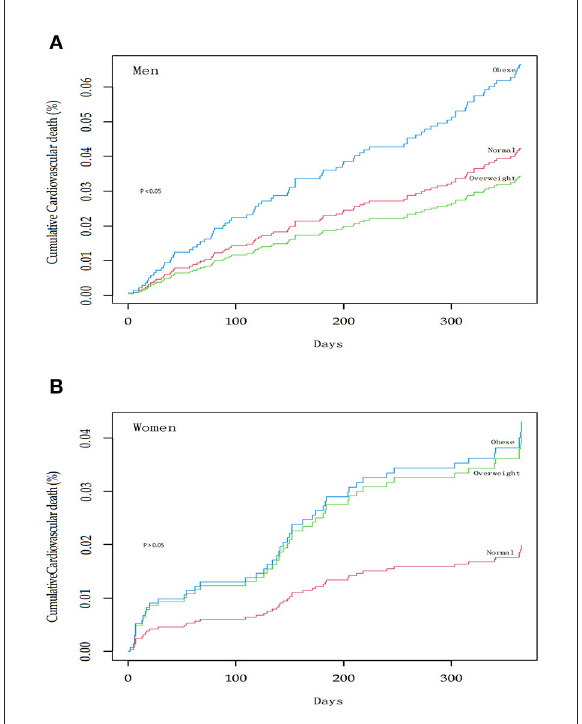
FIGURE2 Cumulative incidence of 1-year cardiovascular death according to category of body-mass index at the base-line examination. The body-mass index was 18.5–24.9 in normal subjects, 25.0–29.9 in overweight subjects, and 30.0 or more in obese subjects. (A) One-year cumulative cardiovascular death in men. (B) One-year cumulative cardiovascular death in women.